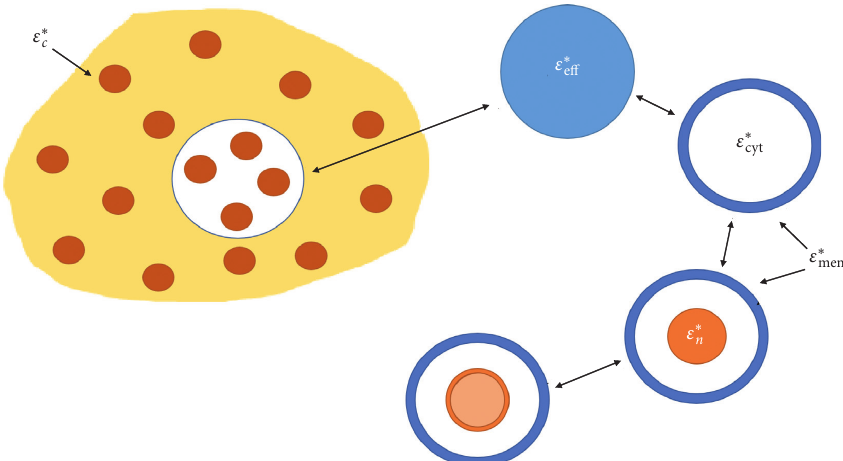
of a cell inside the suspension. eff